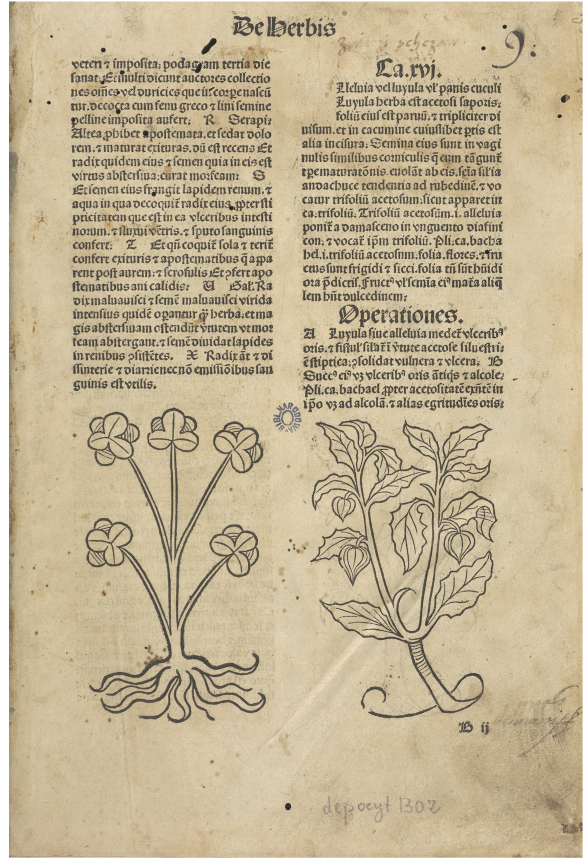
Figure 6. Meydenbach, Iacobus (1491). https://polona.pl/item/Eadem,hortus-sanita- tis,MTExNzkwOTEx/28/#info:metadata (accessed on 17 July 2022).